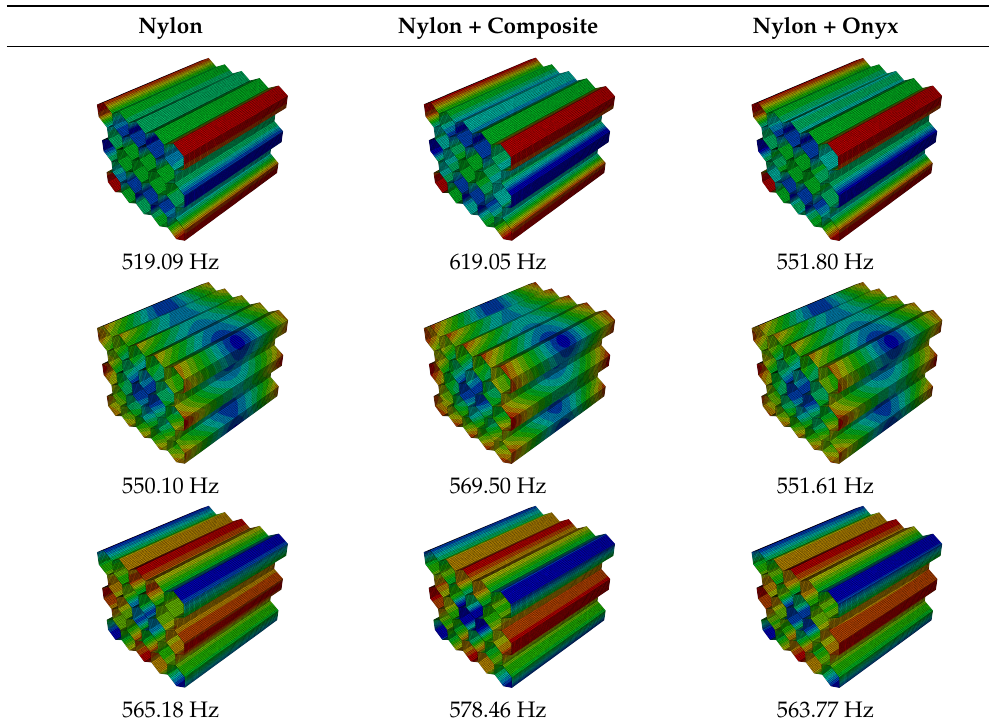
Table 4. Cont. Nylon Nylon + Composite Nylon + Onyx